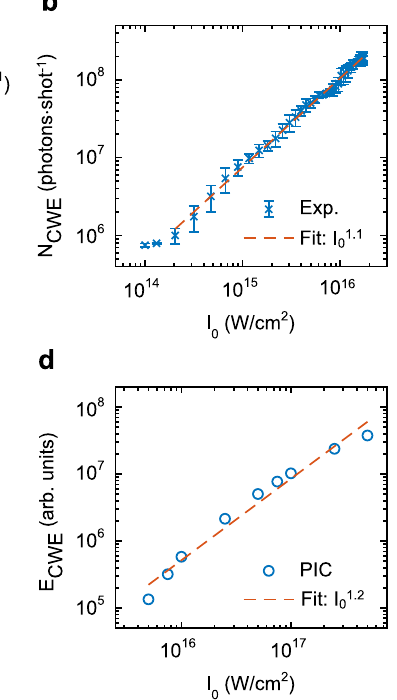
spectra ( d ) between 6 : 5 ω 0 and 14 : 5 ω 0 obtained in 2D PIC simulations obtained at the different peak intensities of the laser pulse. Note that the intensity ranges of experimental results ( a , b ) and PIC simulations ( c , d ) are different because the experimental results could not be observed at high intensities due to the low temporal contrast of the laser